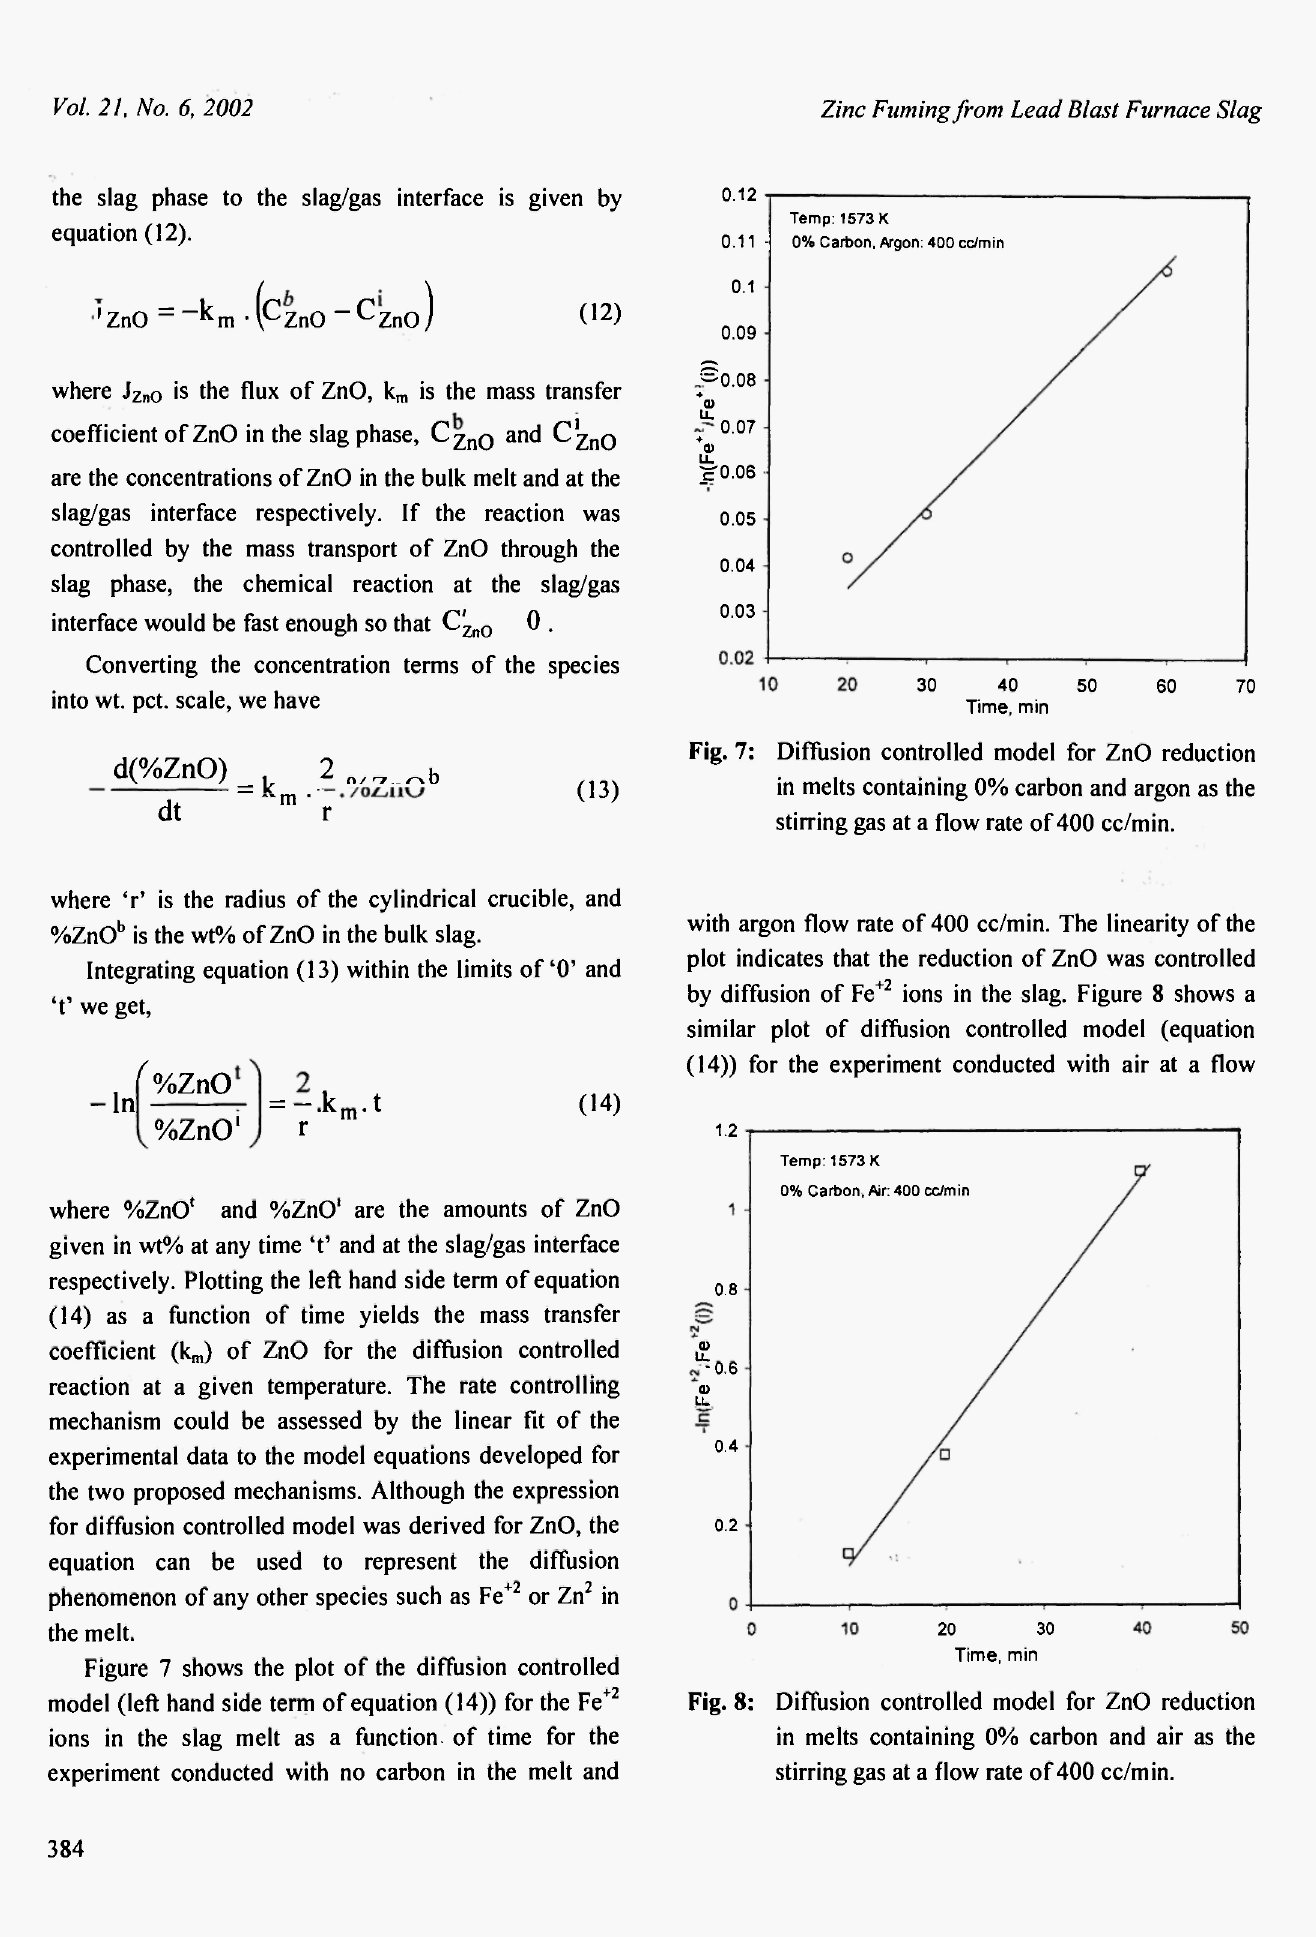
Fig. 7: Diffusion controlled model for ZnO reduction in melts containing 0% carbon and argon as the stirring gas at a flow rate of 400 cc/min.